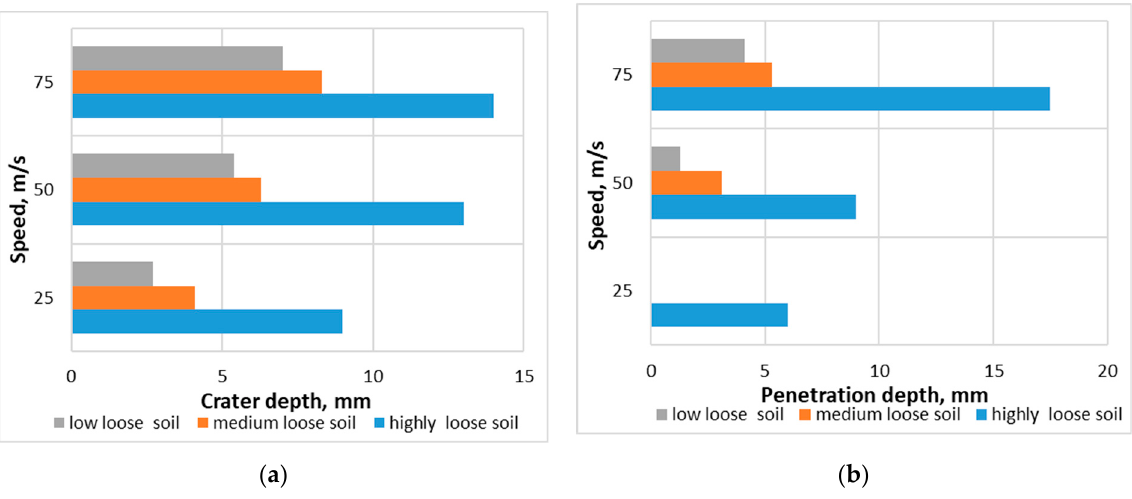
Figure 21. Average crater depths ( a ) and penetration depths of pelleted seeds ( b ) on different types of soils.